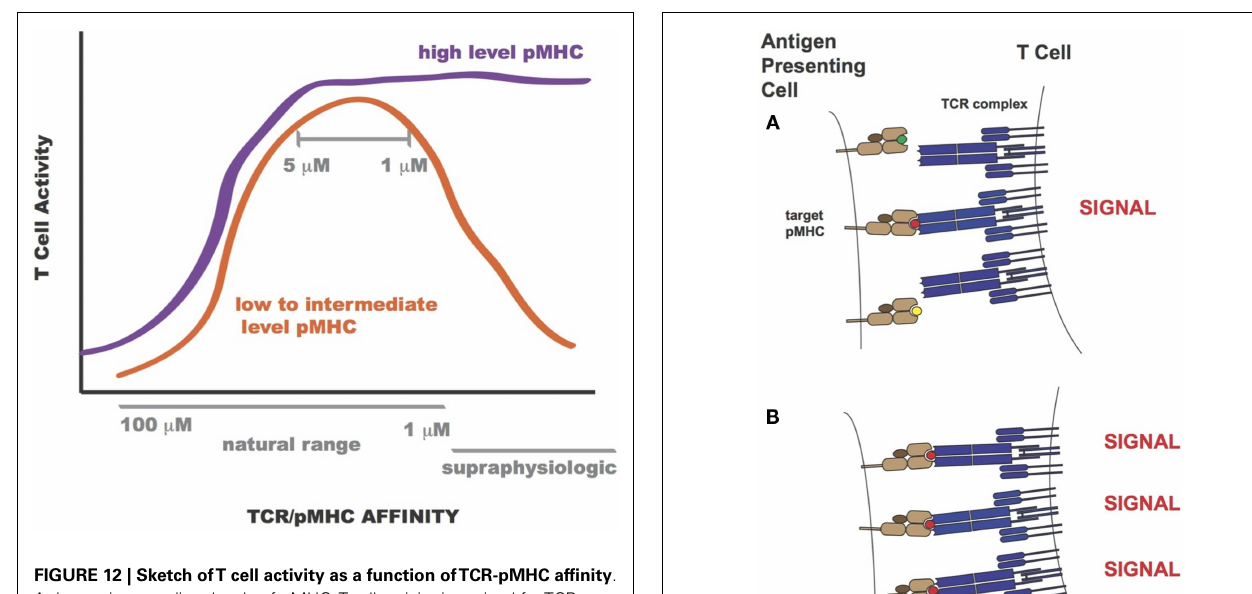
FIGURE 12 | Sketch ofT cell activity as a function ofTCR-pMHC affinity . At low to intermediate levels of pMHC,T-cell activity is optimal forTCR within K D range 1–5 µ M (orange curve). At high levels of pMHCT-cell activity is not attenuated for supraphysiologic affinityTCR (purple curve).